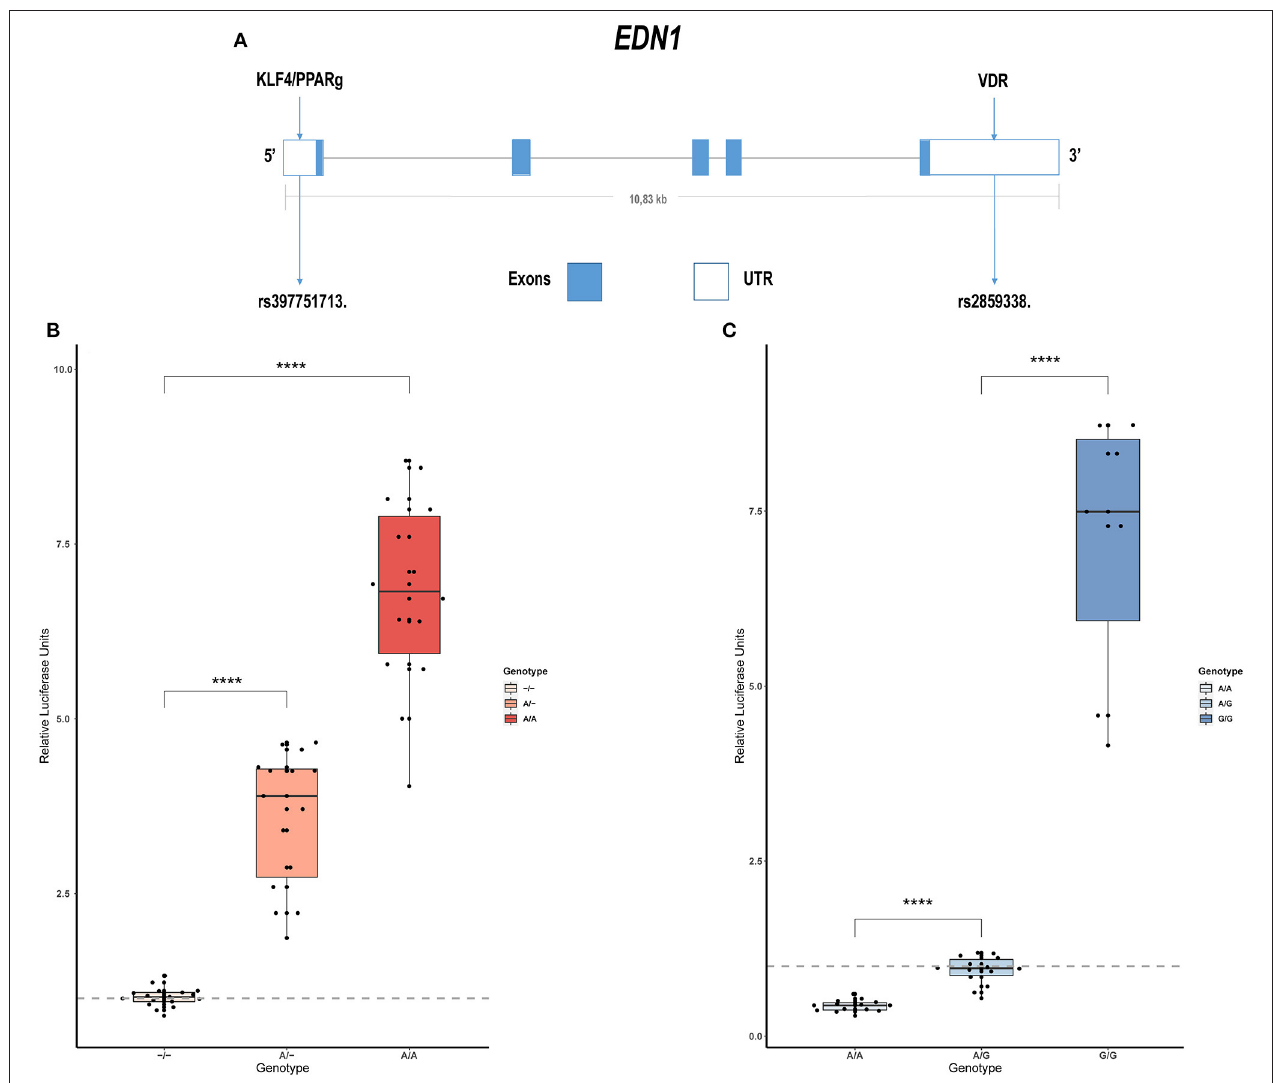
FIGURE 1 | Common variants in EDN1 regulatory regions show different activities depending on the genotype. (A) Schematic view of the EDN1 gene with the location of the SNPs and the predicted transcription factors to interact with them. (B) Comparison of the different genotypes of rs397751713 show increased activity in the A/A genotype and A/- when compared to the commonest genotype –/– ( n = 6). (C) Comparison of the different genotypes of rs2859338 show increased G/G genotype activity and reduced activity in A/A compared with the commonest genotype A/G ( n = 4). Data are represented as box plots depicting the quartiles and dots representing technical replicates. A Kruskal-Wallis test with a Dunn’s correction was used for statistical analysis (**** p > 0.0001). EDN1,